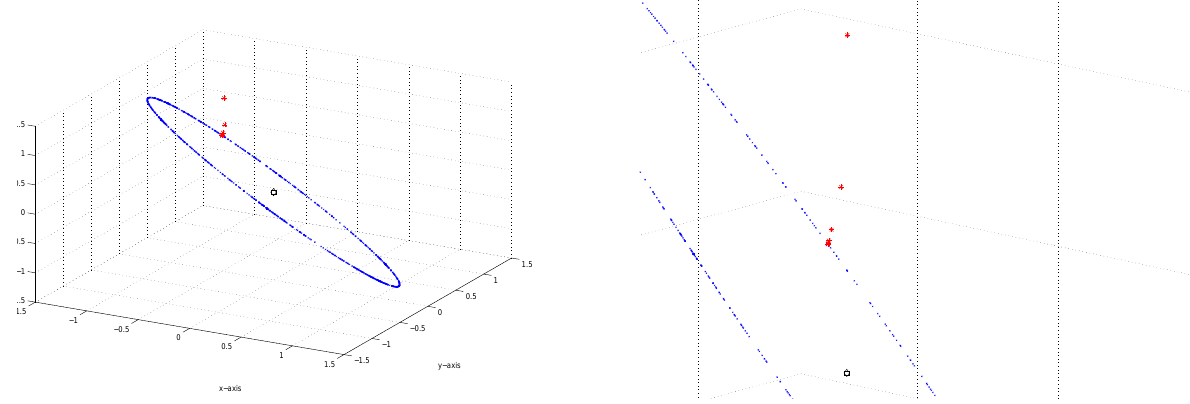
Figure 13. (Left) Example of convergence to set of fixed points, (Right) Close-up of Example.